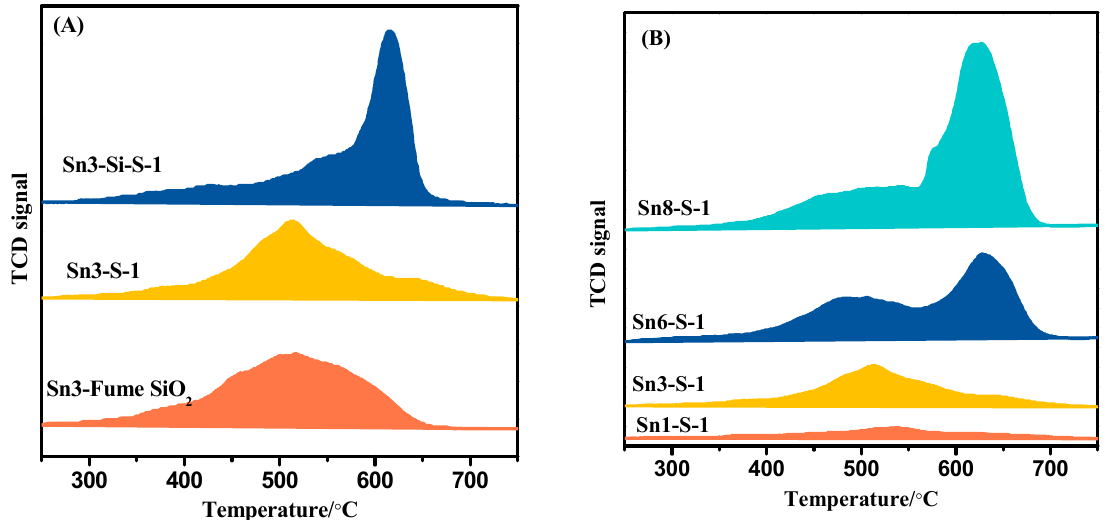
Figure 3. H 2 -TPR profiles of Sn-containing catalysts with different matrixes ( A ) and the Sn-containing defective S-1 zeolite catalysts with different Sn loadings ( B ).